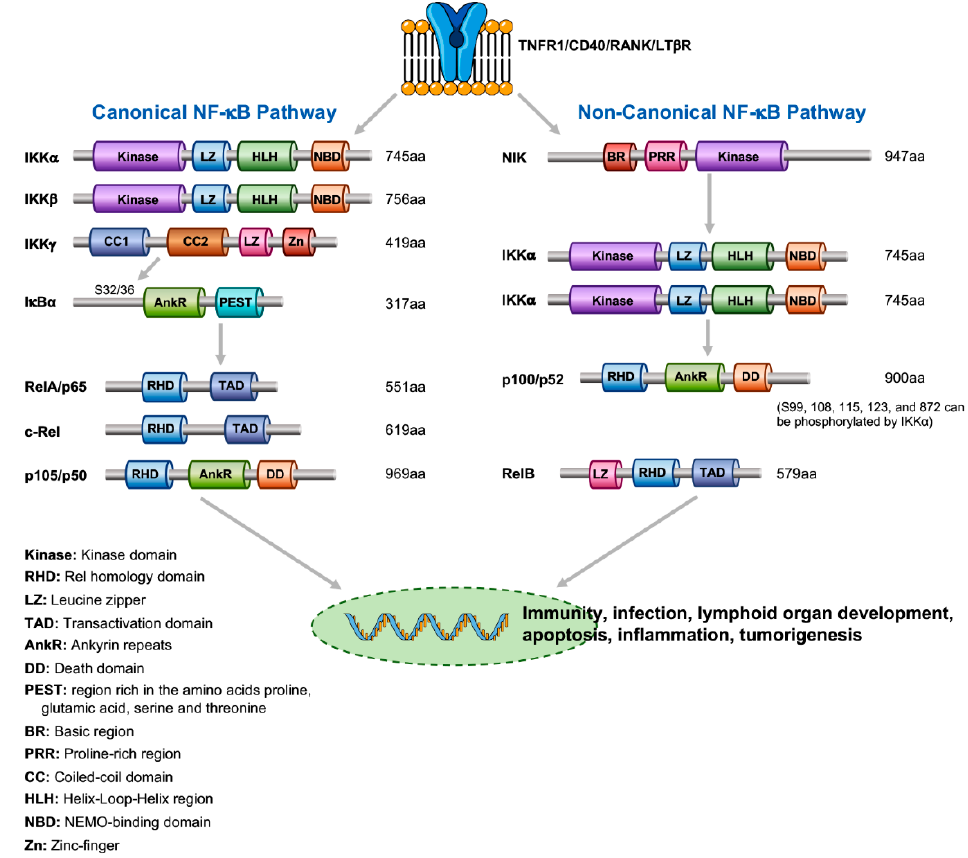
Figure 1. A model of canonical and non-canonical NF- κ B pathways. (aa: amino acid; two IKK α molecules form a homodimer in the non-canonical NF- κ B pathway).